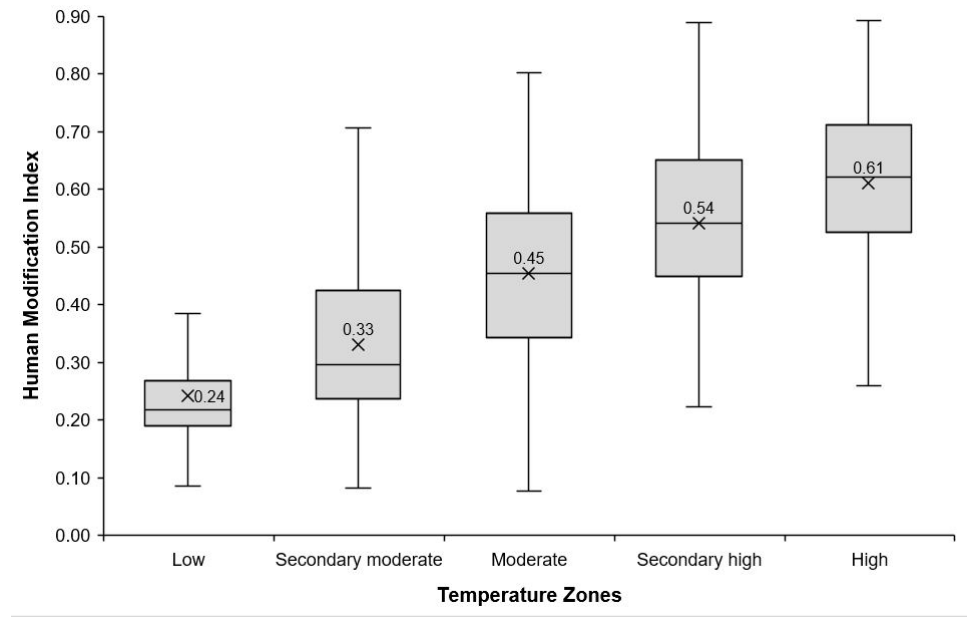
Figure 6. The distribution of human modification in the temperature zones in 2016.